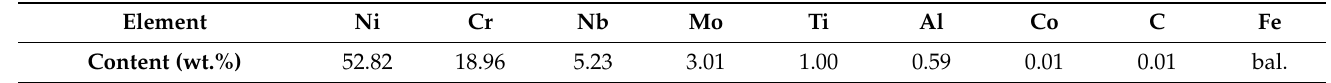
Table 1. Chemical composition of studied GH4169